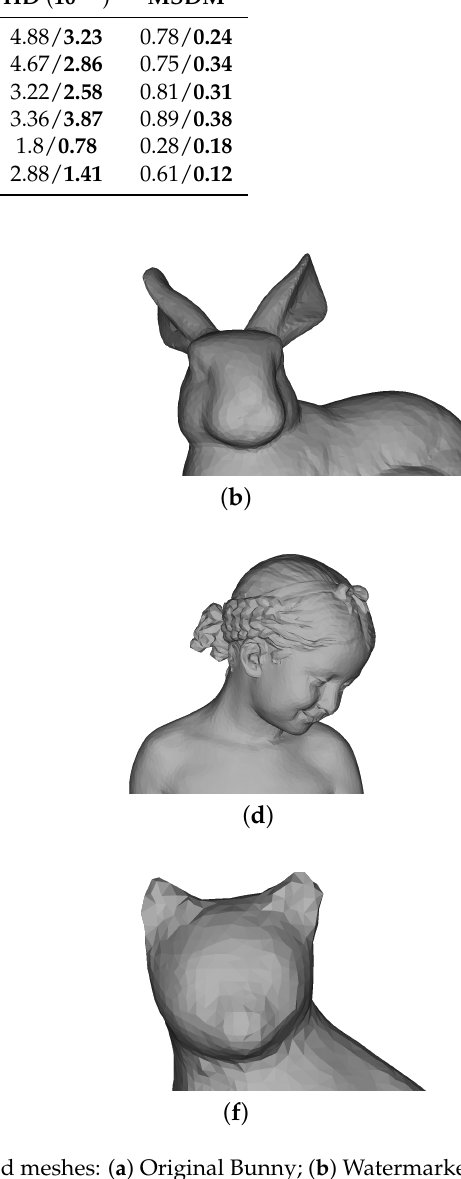
Figure 10. Closeups of the original and watermarked meshes: ( a ) Original Bunny; ( b ) Watermarked Bunny; ( c ) Original Bimba; ( d ) Watermarked Bimba; ( e ) Original Cat; ( f ) Watermarked